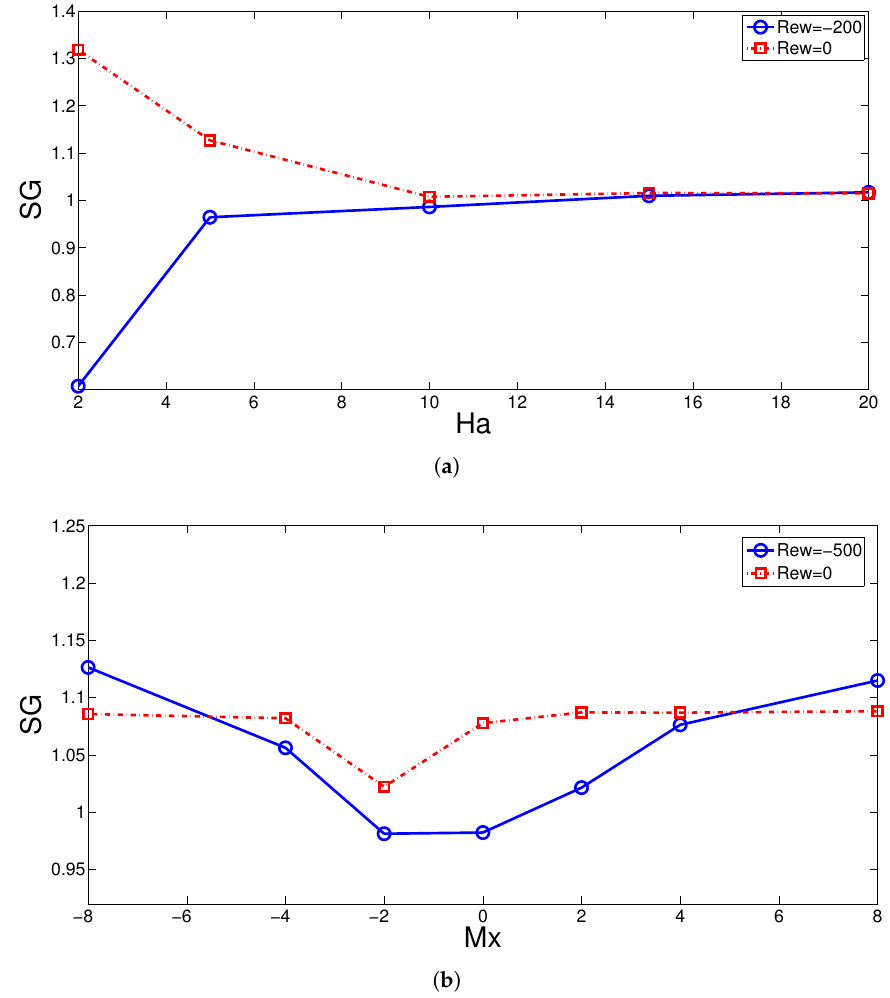
Figure 11. Effects of MGF strength ( a ) horizontal location of the CCs ( b ) on the variation of EG considering rotating and non-rotating CC cases (VR = 0.25, Mx = −